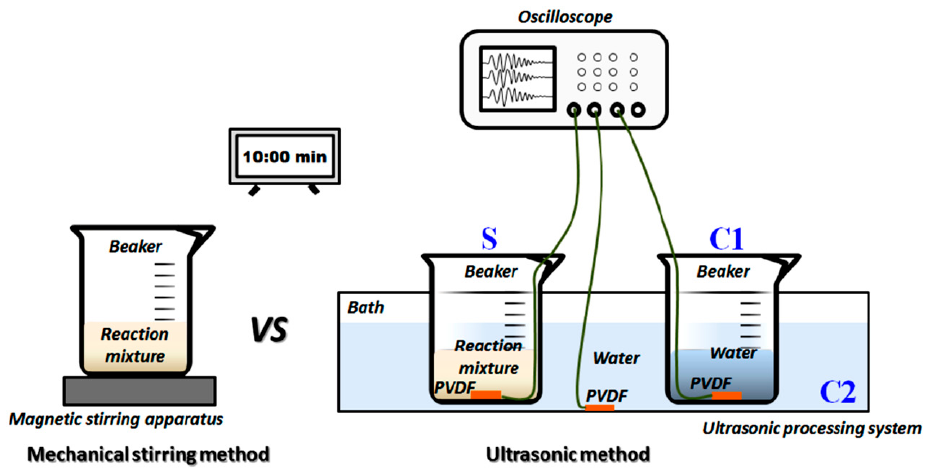
Figure 4. Schematic diagram of monitoring of ultrasonic fields during synthesis process of nano-ZnO [69].